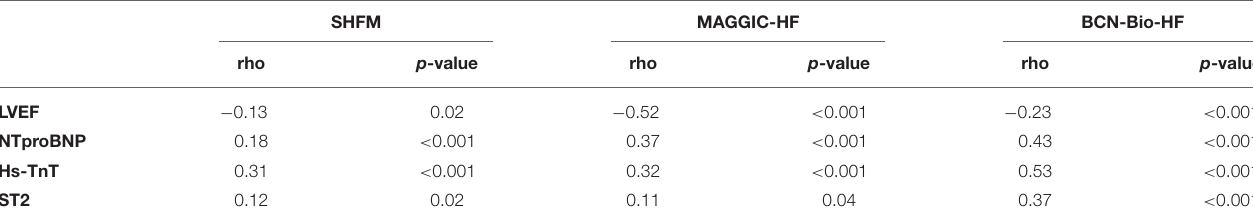
TABLE 2 | Correlation between relative changes in all-cause death risk at 1 year for every calculator and relative changes in LVEF and biomarkers. SHFM MAGGIC-HF